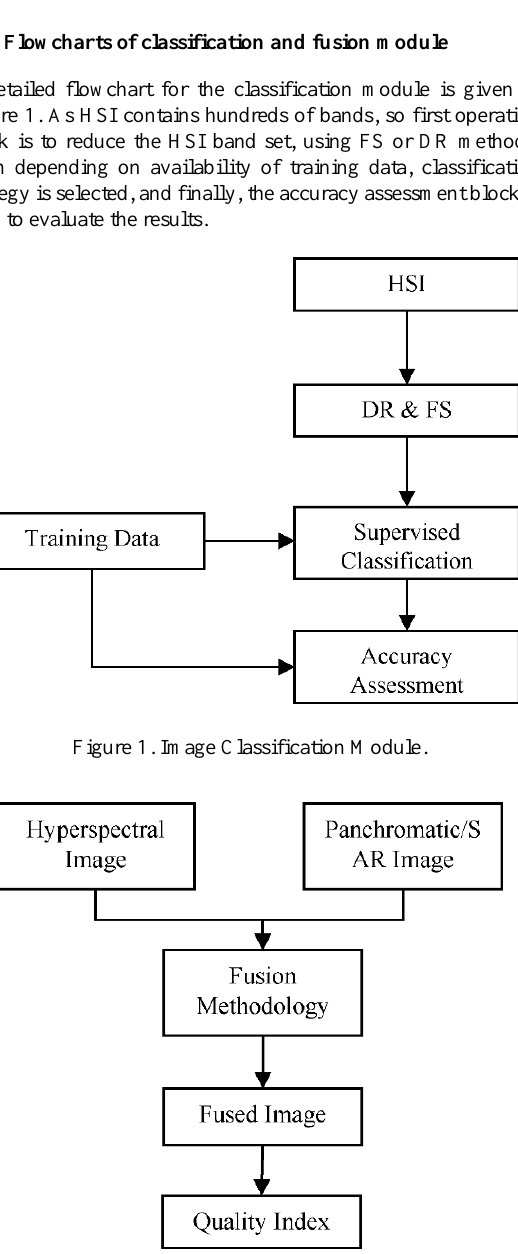
Figure 2. Image Fusion